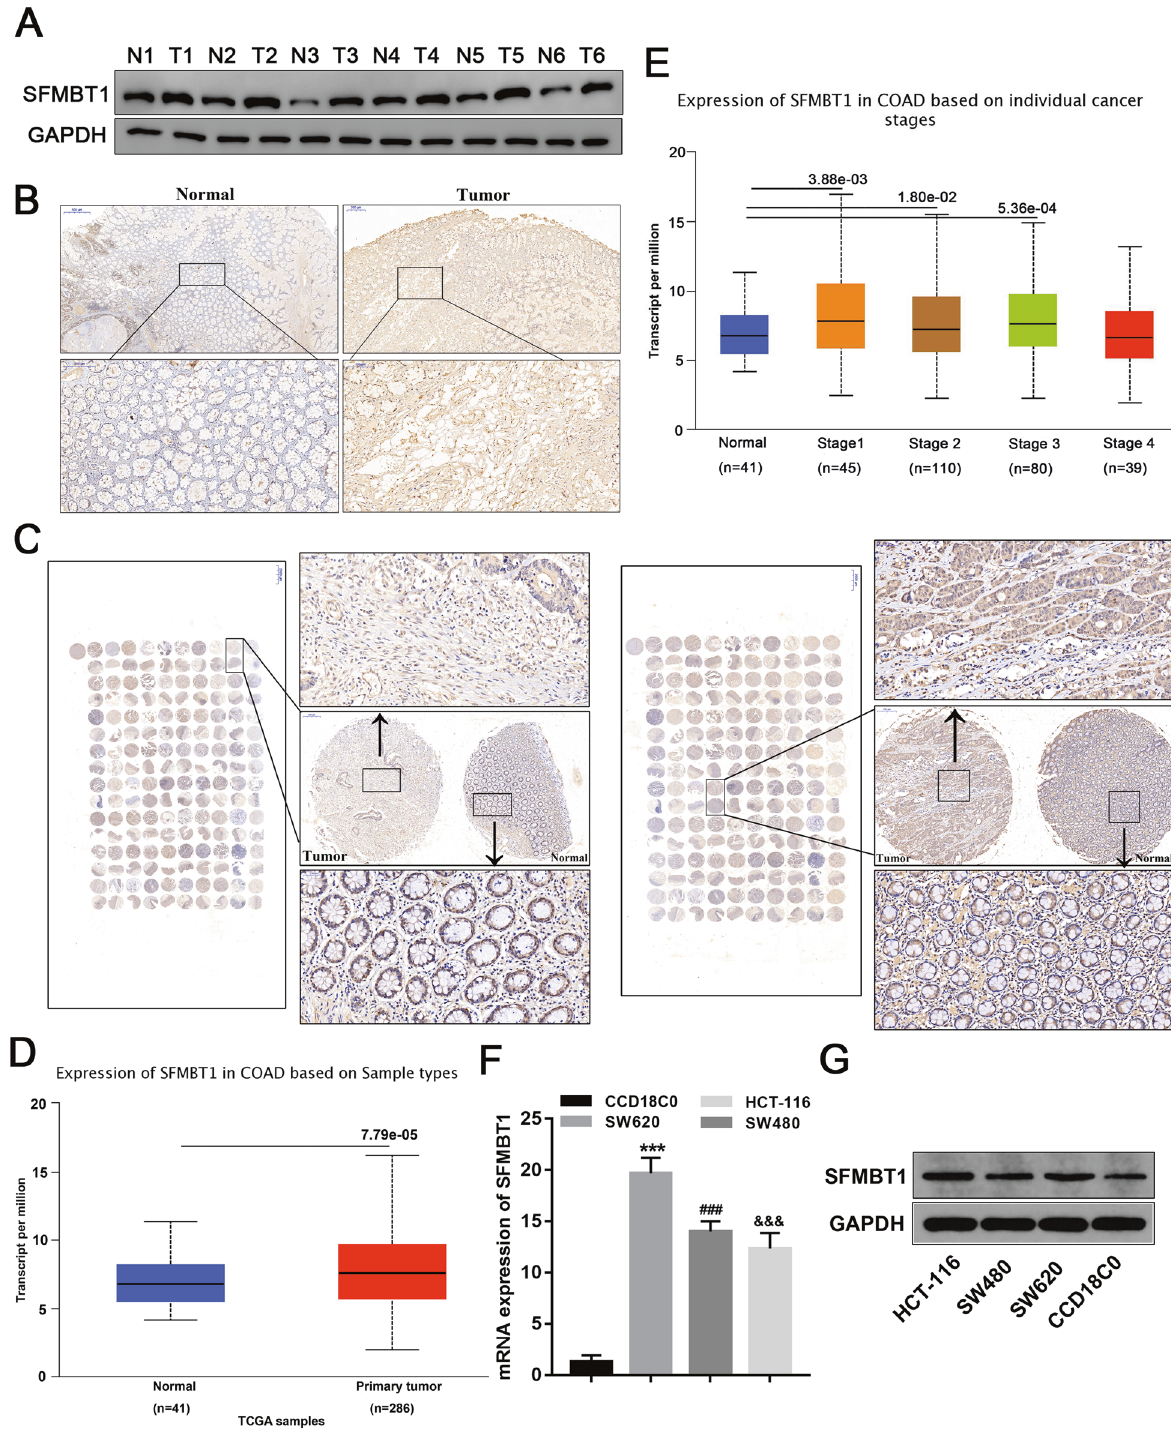
Fig. 1 Distribution of SFMBT1 in colorectal cancer (CRC) tumor tissues and cells. A Western blot analysis of SFMBT1 protein levels in normal and tumor tissues. ( n = 6) ( B ) Expression of SFMBT1 in normal and CRC tumor tissues were examined by immunohistochemistry. C Expression of SFMBT1 in CRC tissue microarrays. D , E TCGA data shows the expression of SFMBT1 in tumor tissues and normal tissues or in different cancer stages. F , G qRT-PCR ( F ) and western blot analysis ( G ) detect SFMBT1 mRNA and protein in human colorectal epithelial cells CCD18C0 and CRC cell lines HCT-116, SW620 and